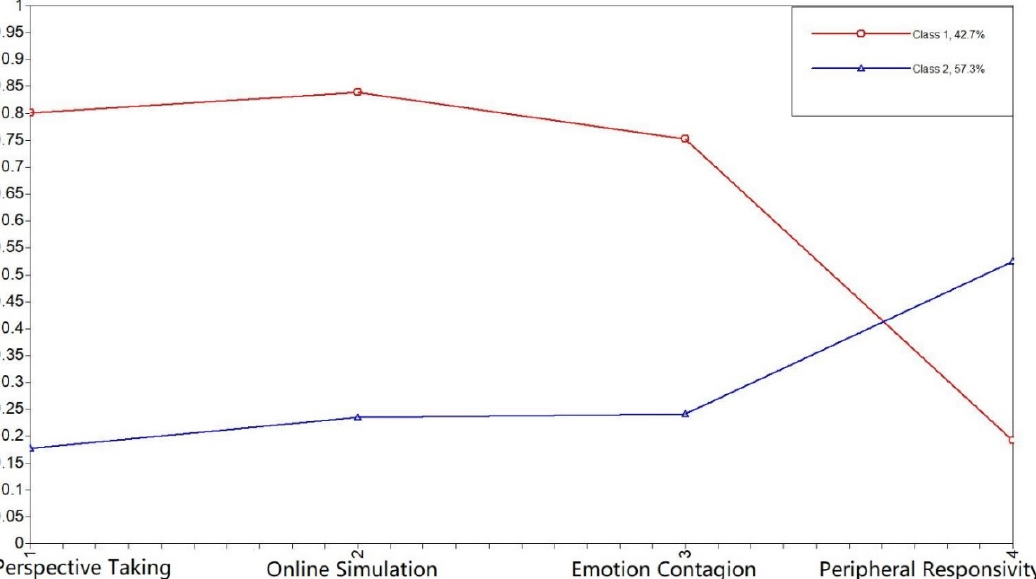
Figure 6. Plot of class-specific response probabilities for each of four subscales of Empathy for Chinese in Russia. Note: our previous work showed that a four-factor structure performs better for the Chinese sample.